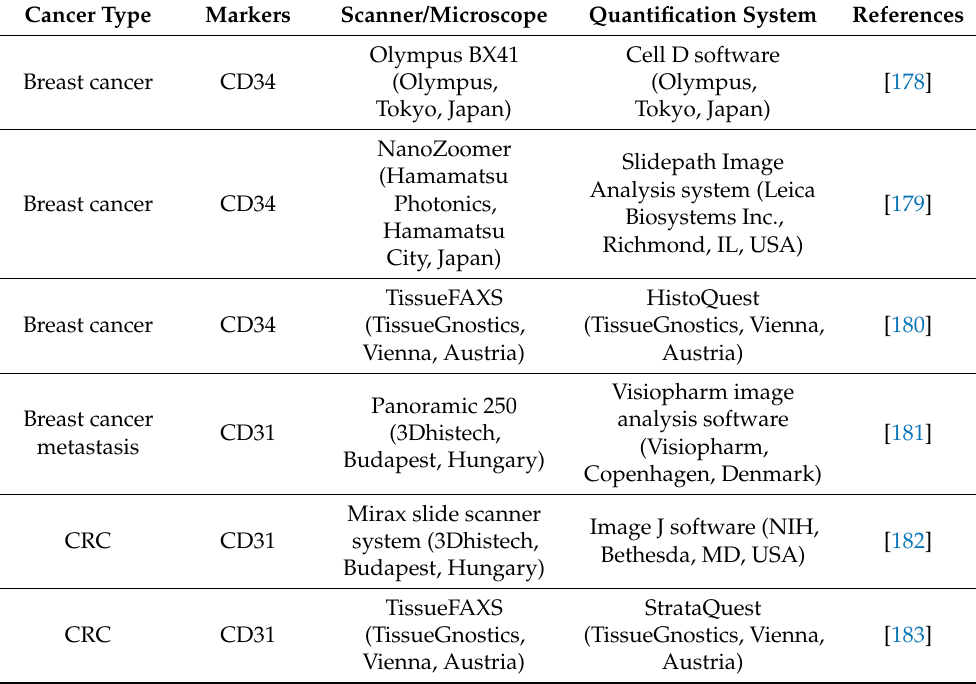
Table 3. Studies using next-generation digital pathology for the quantification of blood